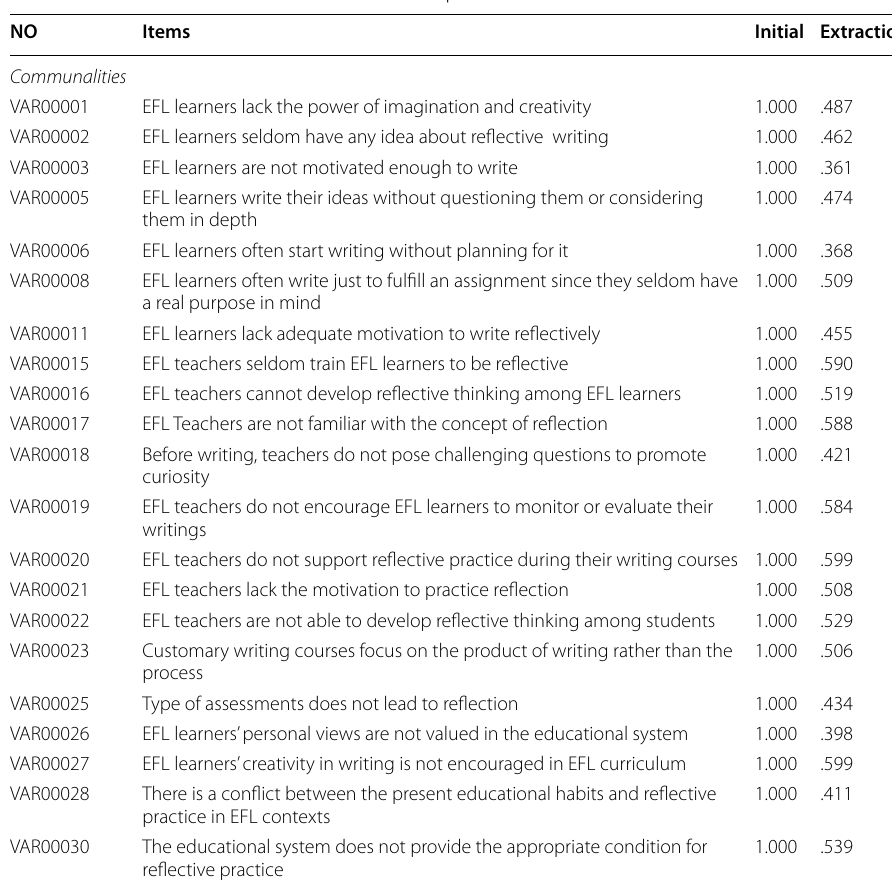
Table 4 The communalities of the items of the